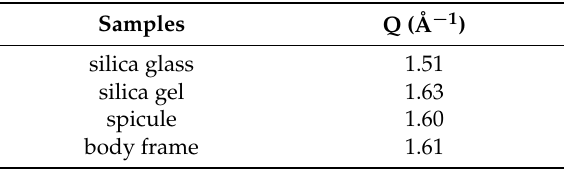
Table 4. FSDP positions Q of X-ray scattering profiles for samples (Q is 4 π sin θ / λ : λ is wavelength of